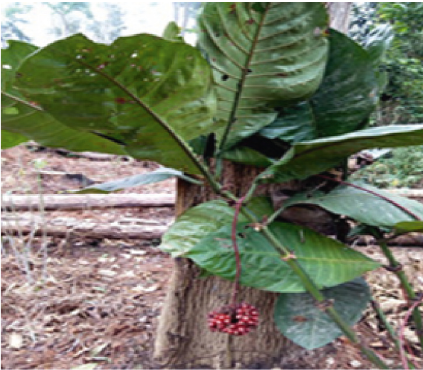
Figure 1: Psychotria densinervia (photo taken by Dr. Tsabang Nole,